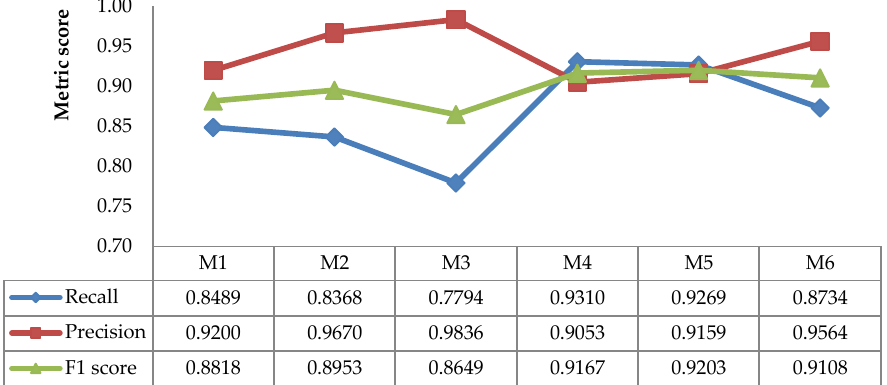
Figure 12. Average recall, precision, and F1 scores of static image methods.